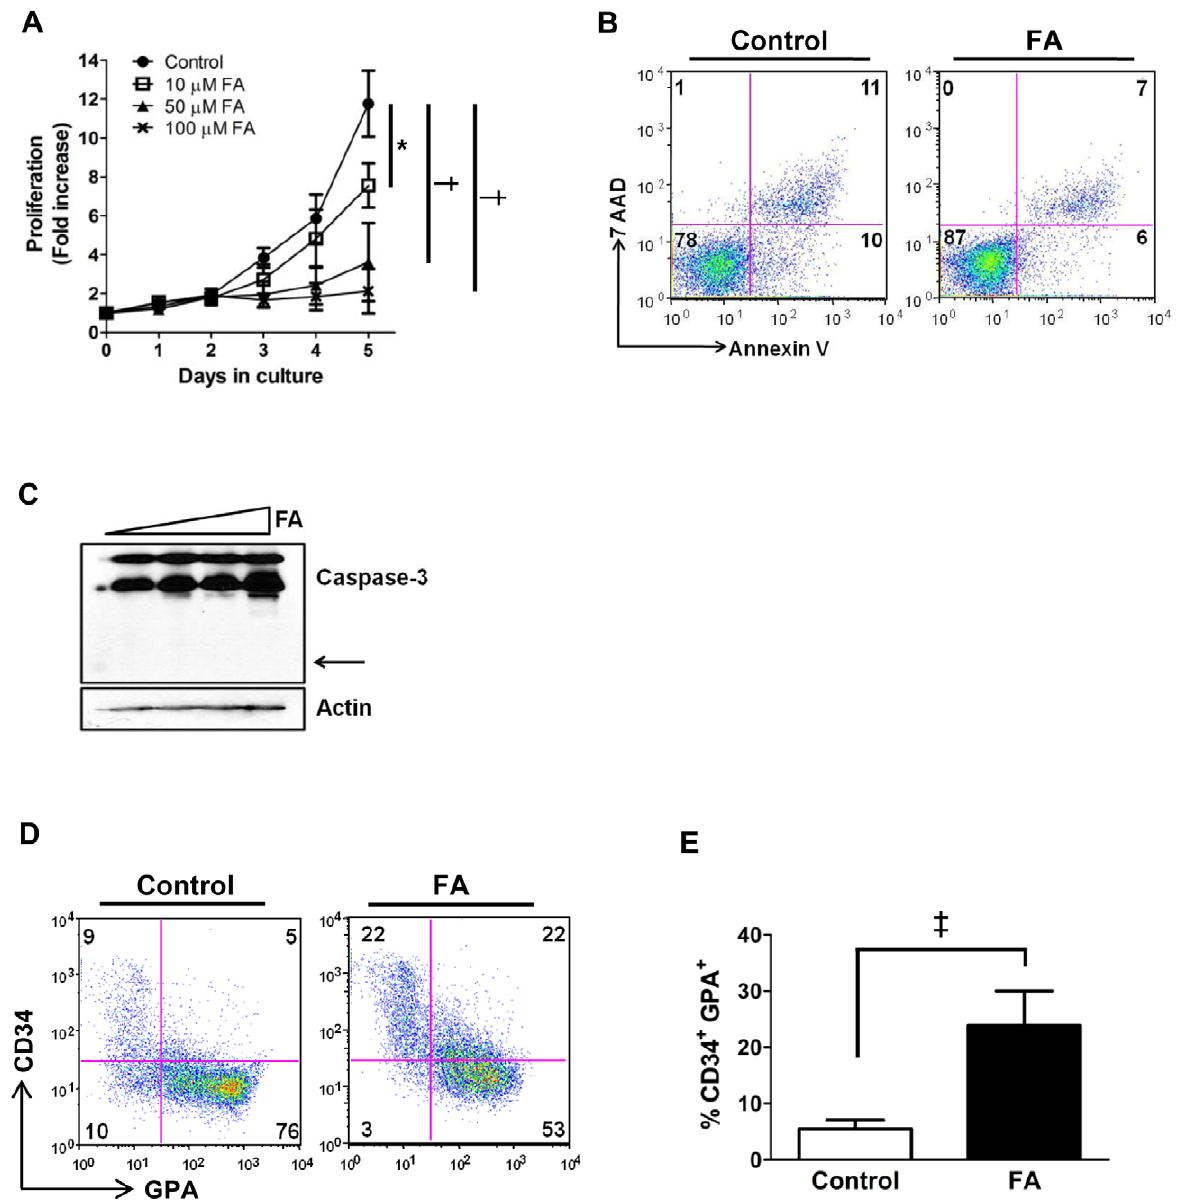
Figure 3. Effects of aconitase inhibition on erythroid proliferation, survival and maturation in vitro. ( A ) Fold increase in number of primary human progenitors cultured for five days in erythroid medium with the indicated doses of FA. Shown are mean 6 SD for three independent experiments; * P , 0.05; { P , 0.01. ( B ) Survival of cells from day 5 erythroid cultures 6 50 m M FA assessed by staining with 7-amino actinomycin D (7- AAD) and annexin V-PE followed by flow cytometry; numbers indicate percentages of cells in each quadrant. ( C ) Apoptotic signaling in cells from day 5 erythroid cultures with 0, 10, 50, and 100 m M FA assessed by immunoblotting of whole cell lysates for caspase-3 (arrow indicates position of cleavage product). ( D ) Differentiation of erythroid progenitors cultured as in panel B . Surface expression of CD34 and GPA was assessed by flow cytometry on live cells; numbers indicate percentages of cells in each quadrant. ( E ) Multiple independent experiments as in panel D show an increase in the percentage of CD34 + GPA + cells associated with FA treatment. Shown are mean 6 SD; n=6; { P , 0.001.